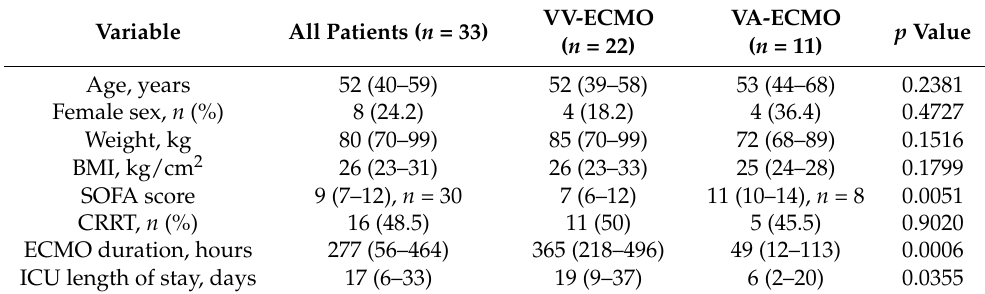
Table 1. Baseline patient characteristics.